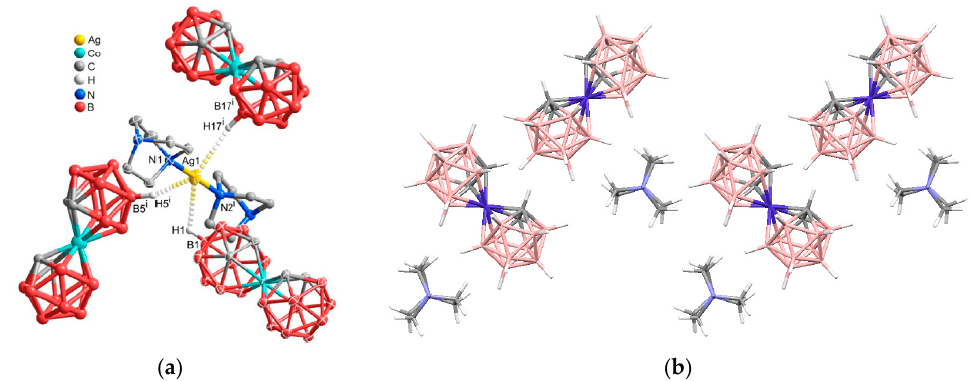
Figure 112. X-ray structure of {Ag(DABCO)[3,3’-Co(1,2-C 2 B 9 H 11 ) 2 ]} n : coordination arrangement of silver cation ( a ) and crystal packing ( b ). Reprinted with permission from reference [77]. Copyright © (2013) American Chemical Society.